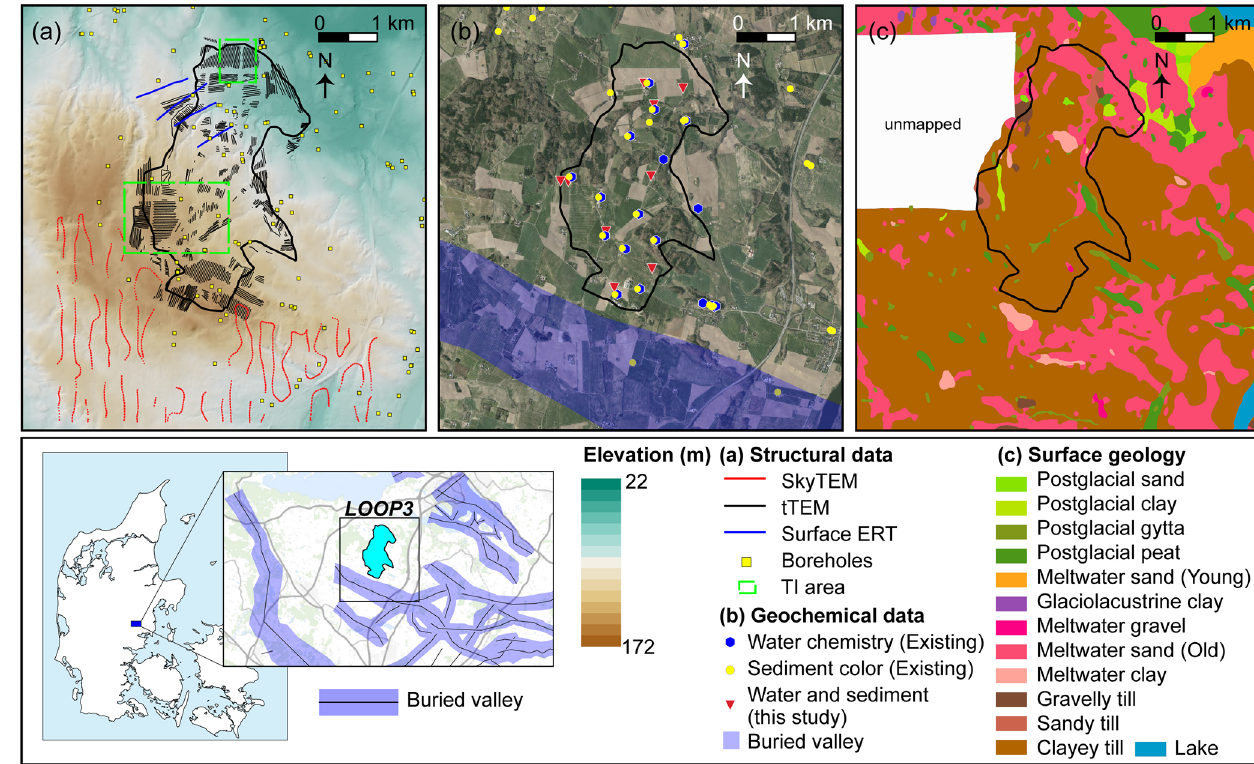
Figure 1. The study area and available data, where (a) displays a digital terrain model, geophysical data and outlined TI areas, (b) an orthophoto (from Geodatastyrelsen, ortophoto forår, WMS Service, March 2021) and geochemical data, and (c) a surface geology map (1m below surface, Jakobsen and Tougaard, 2020). Insets with a map of Denmark and regional view of the study site with mapped buried valleys (Buried Valleys,